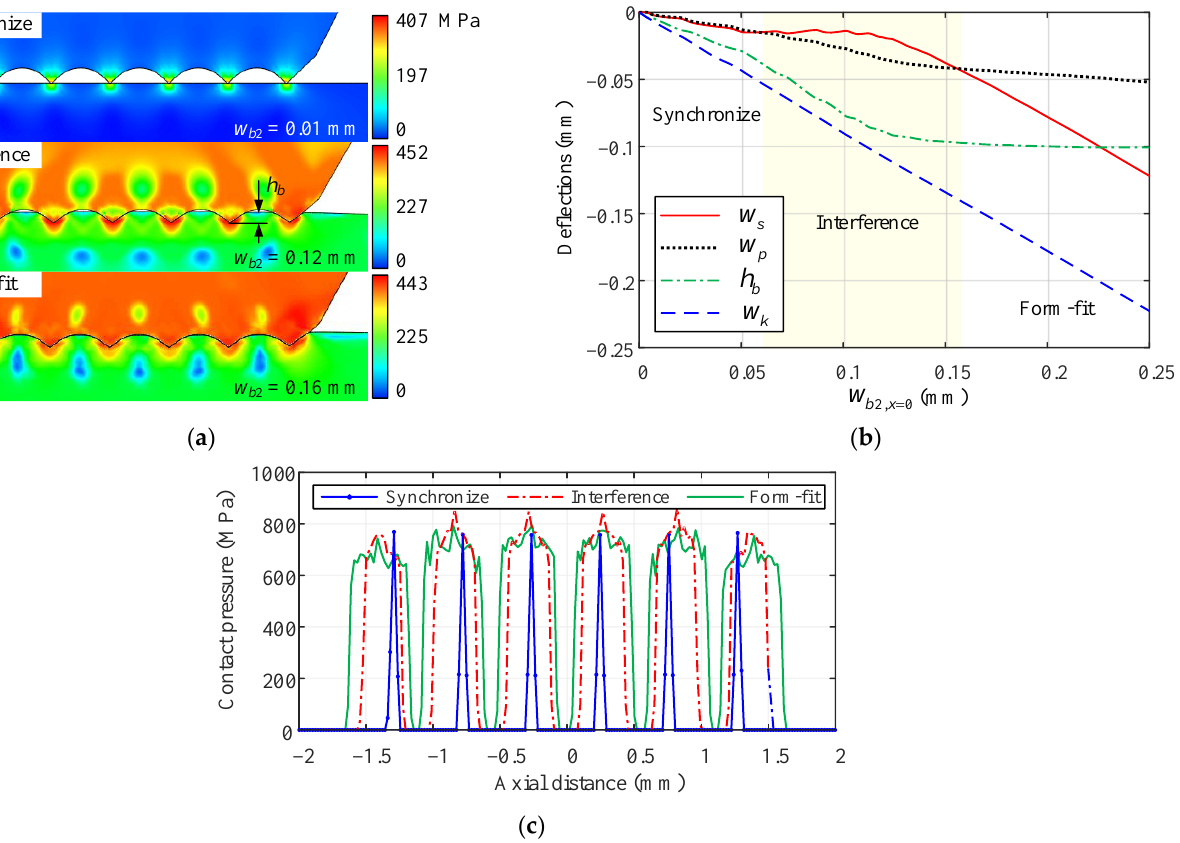
Figure 8. ( a ) Stress contour plots of corresponding deformation phases; ( b ) deflections and embedded depth of the streaks as a function of 𝑤 𝑏2 ; ( c ) contact pressure on the sealing surface.